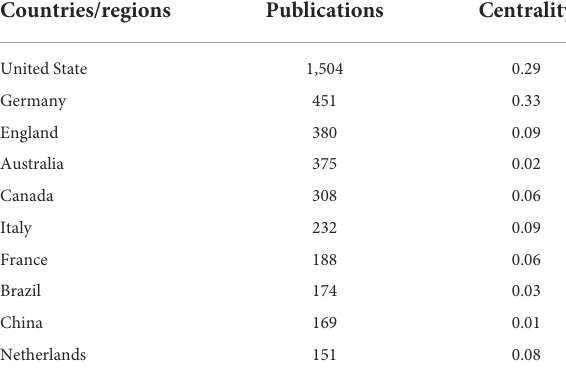
TABLE 2 Top-ten countries with